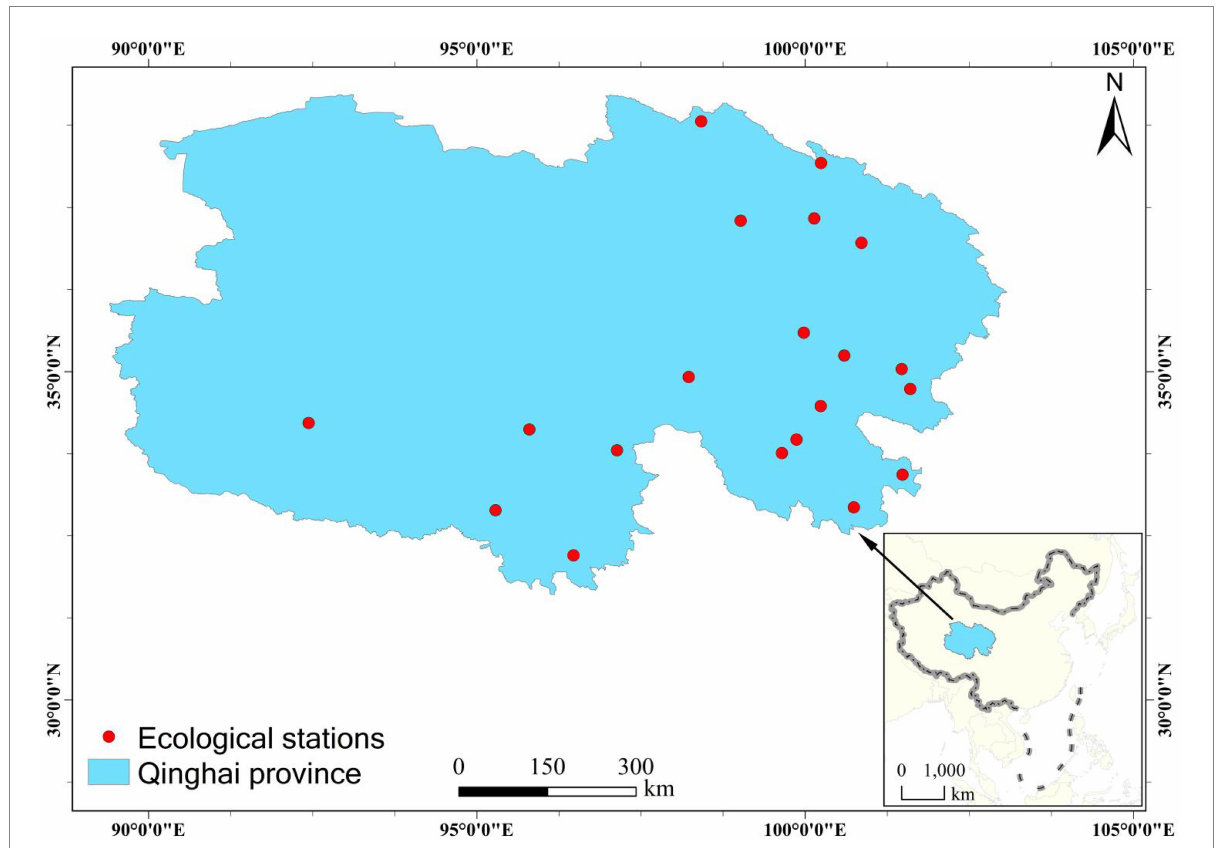
FIGURE 1 Geographical location and distribution of 20 ecological stations in the northeast region of the Qinghai–Tibetan